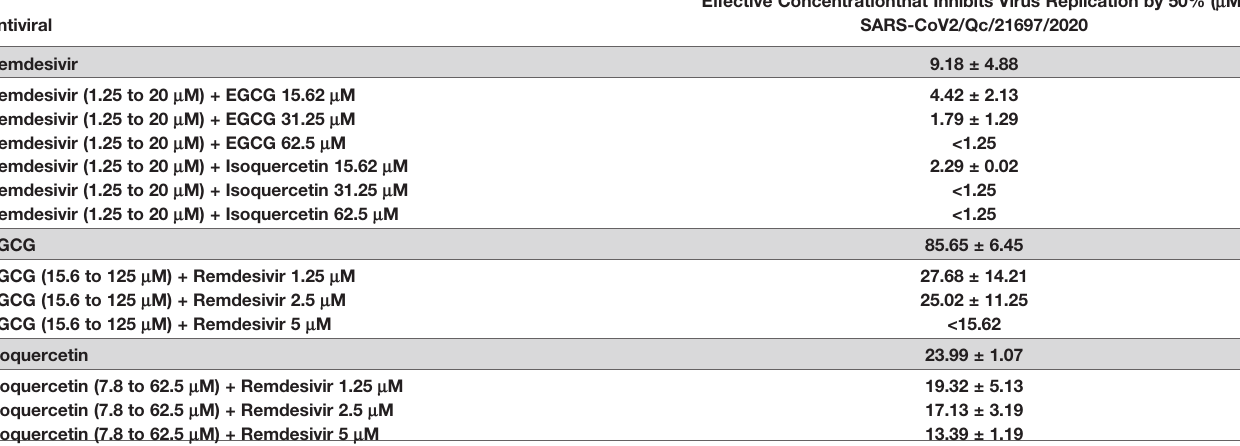
TABLE 1 | Antiviral activity of polyphenols (EGCG or Isoquercetin) and Remdesivir alone or in combination against SARS-CoV-2. EC 50 of one compound alone or combined was determined.